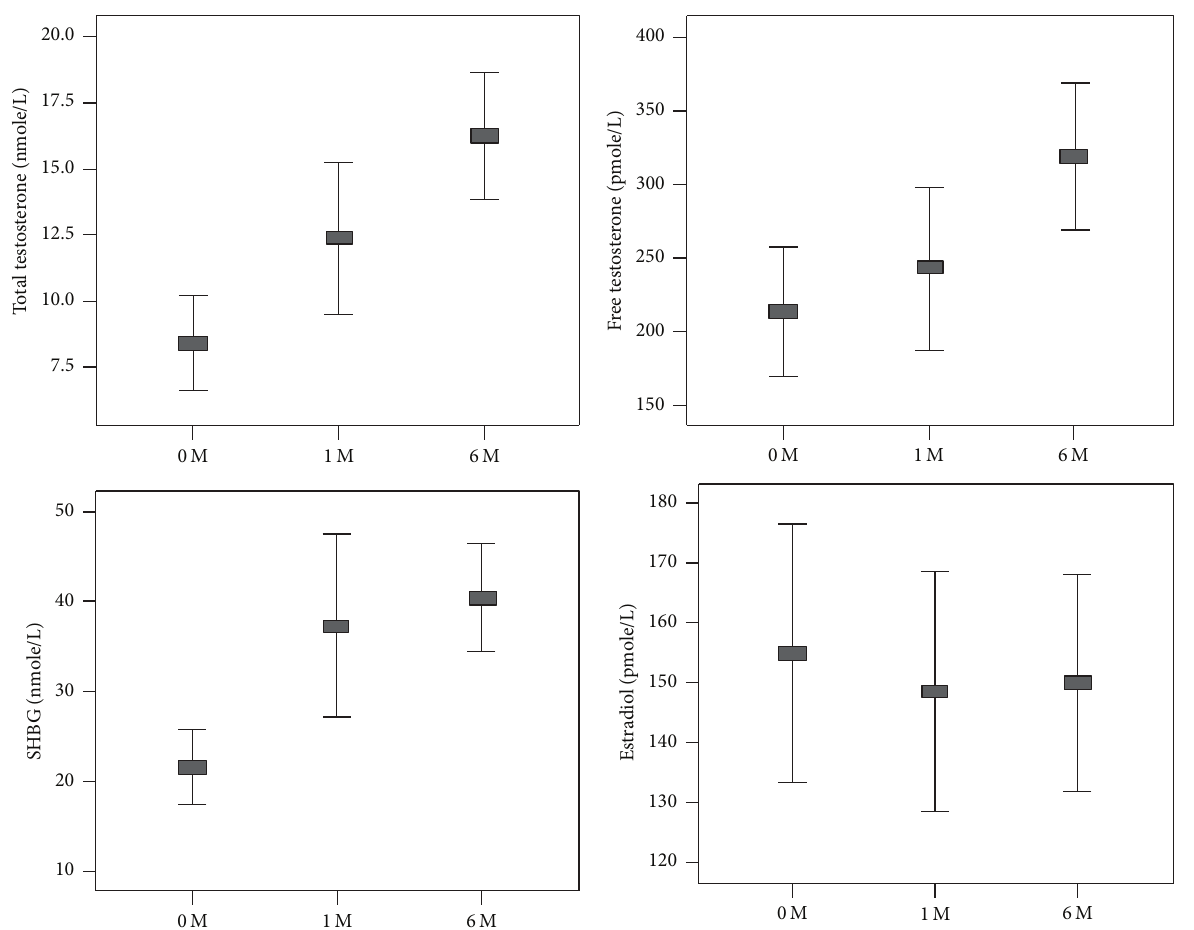
Figure 1: Total testosterone, calculated free testosterone, SHBG, and estradiol at baseline, 1 month and 6 months after bariatric